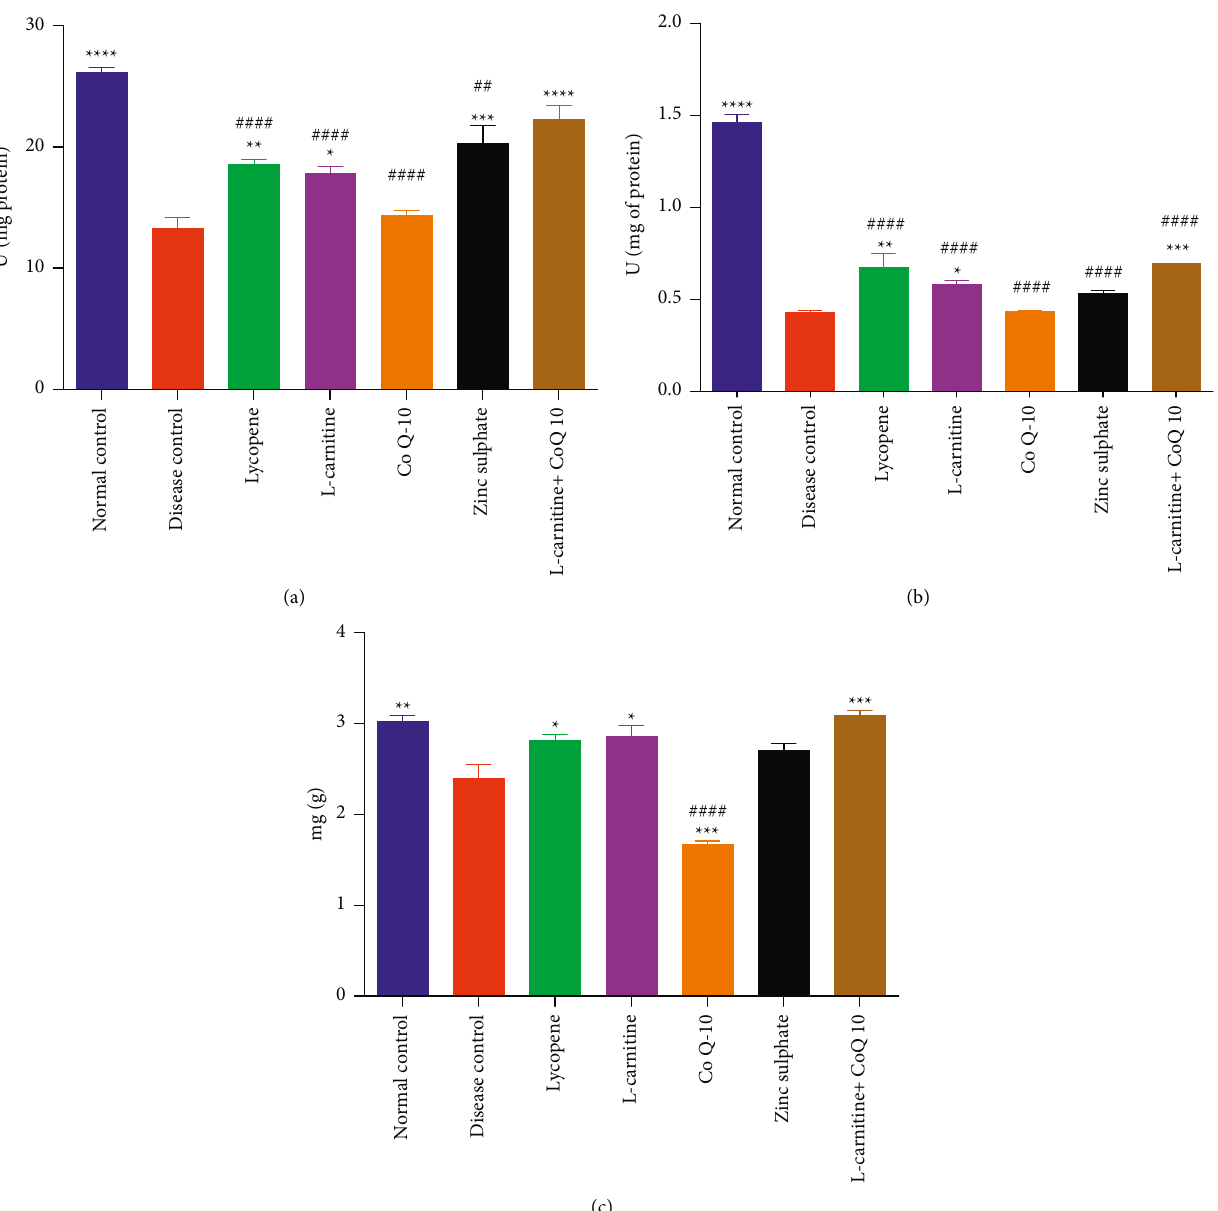
Figure 5: Effect of lycopene, L-carnitine, coenzyme Q10, and zinc sulfate on oxidative stress in testicles of cadmium-exposed rats. Results presented as mean ± S.D. ( n � 10). ∗∗∗∗ , ∗∗∗ , ∗∗ and ∗ showed statistically significant as compared to disease control at P < 0.0001, 0.001, 0.01 and 0.05 respectively, while #### and ## showed statistically significant compared to normal control at P < 0.0001 and 0.01 respectively. (a) Superoxide dismutase. (b) Catalase. (c) Reduced